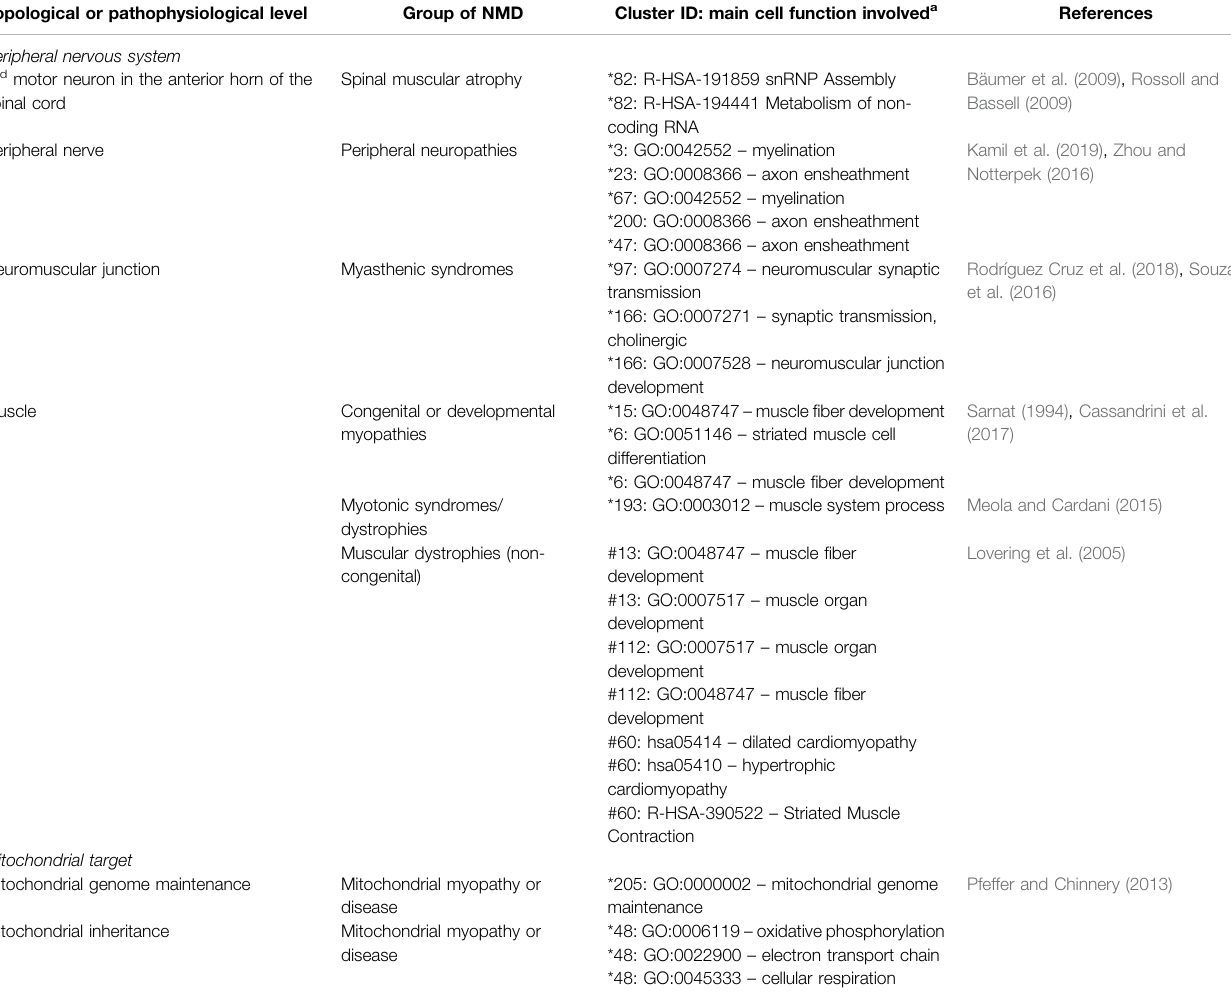
TABLE 7 | Known associations between NMDs, clusters and underlying cell function, sorted by topological and pathophysiological levels. Topological or pathophysiological